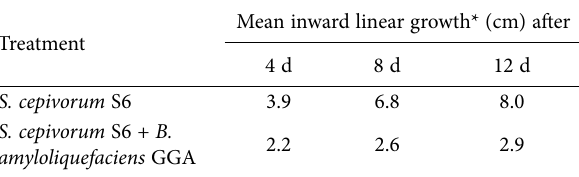
Table 1. Dual culture test between Sclerotium cepivorum S6 and Bacillus amyloliquefaciens GGA.